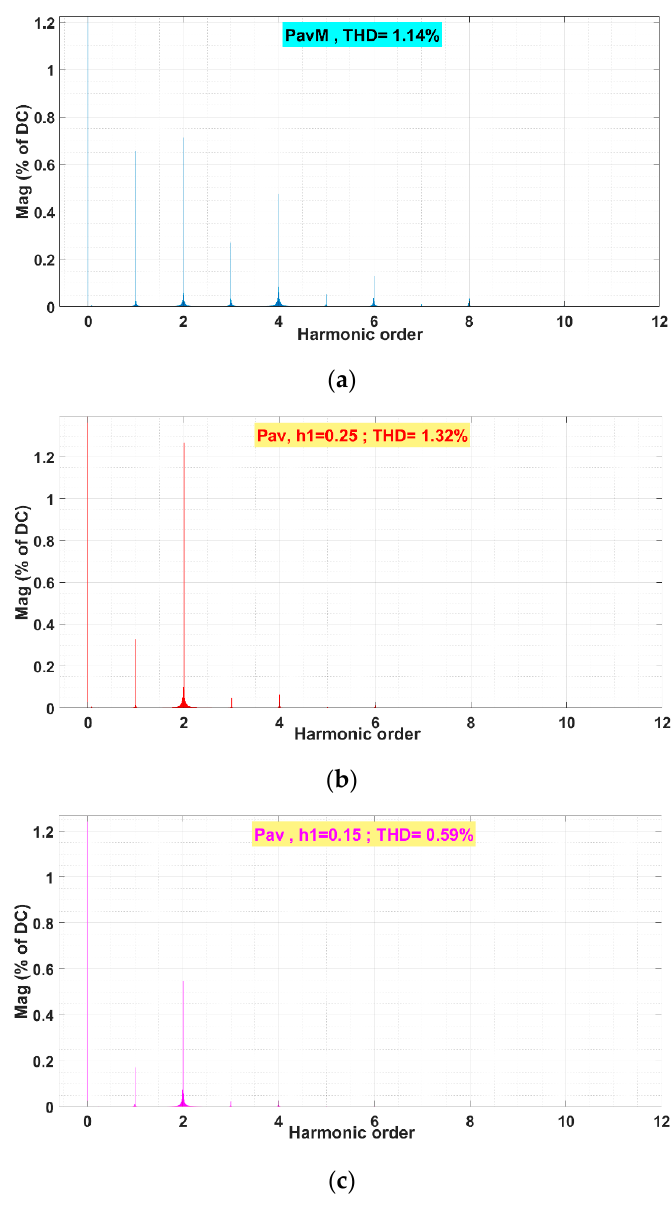
Figure 10. THD with respect DC component calculated, in steady-state, for ( a ) PavM ; ( b ) Pav with h1 = 0.25; and ( c ) Pav with h1 = 0.15.